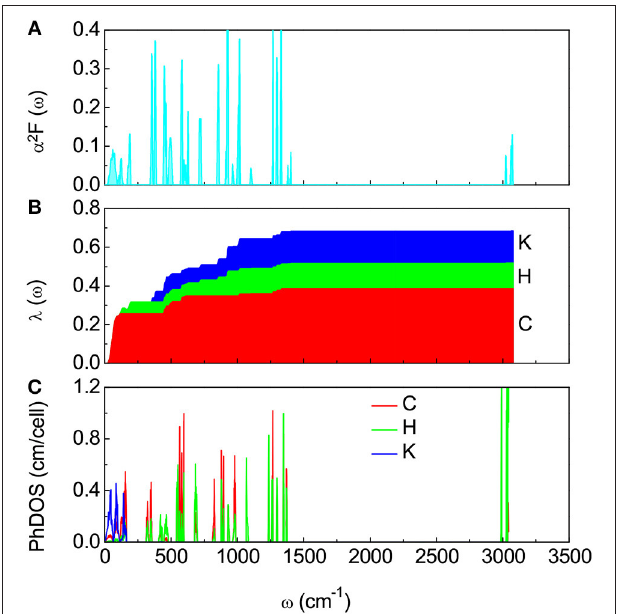
FIGURE 3 | Electron-phonon coupling and phonon density of states of K 2 C 6 H 6 . (A) Electron-phonon coupling Eliashberg spectral function α 2 F ( ω ). (B) Electron-phonon coupling integral λ ( ω ) resolved by projections on C, H, and K phonons. (C) Phonon density of states (PhDOS) of K 2 C 6 H 6 projected on C, H, and K modes. K ( µ ⋆ = 0.1) were obtained for the K 2 C 10 H 8 charged with the